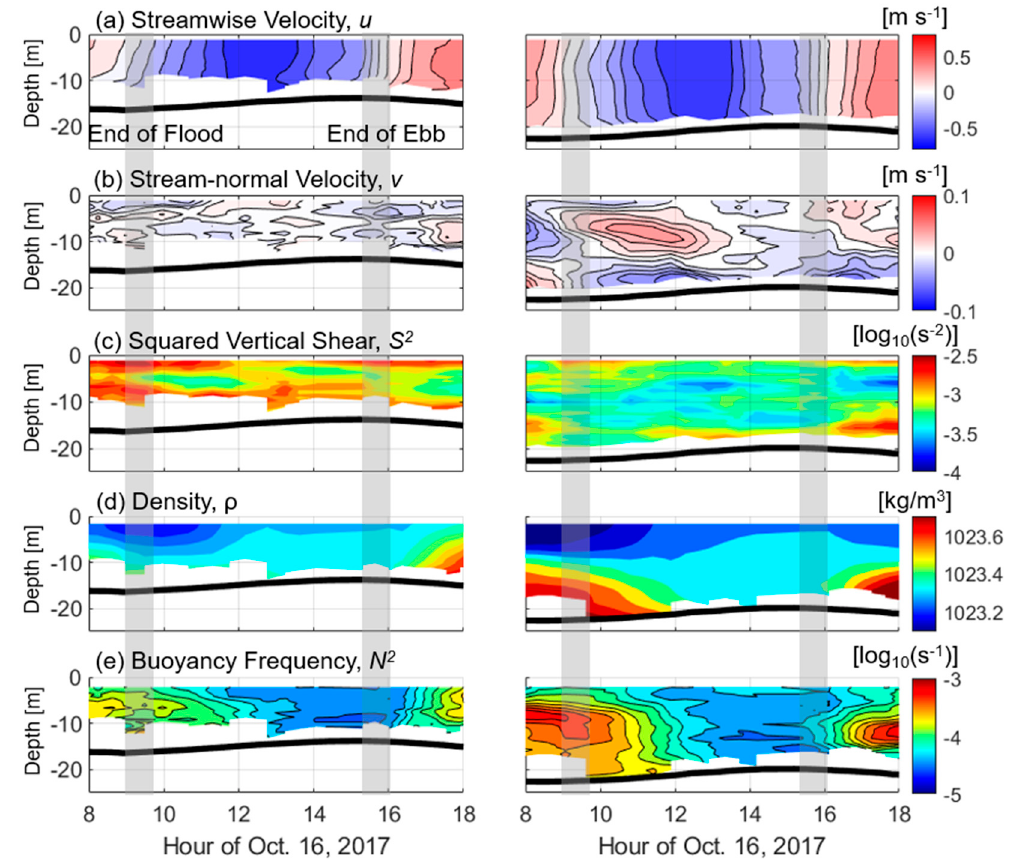
Figure 4. At stations 1 (left panels) and 2 (right panels): ( a ) Streamwise velocity. Positive values represent flow into the estuary; negative represent outflow. ( b ) Stream-normal velocity. Positive depicts flow directed right (when looking landward) and negative is flow directed left. ( c ) Squared vertical shear, S 2 . ( d ) Density, ρ . ( e ) Buoyancy frequency, N 2 . Hour of 16 October 2017 is the x axis of each subplot, and depth is the y axis. Panels ( c ) and ( e ) show log 10 values. Shaded boxes represent the end of flood and ebb